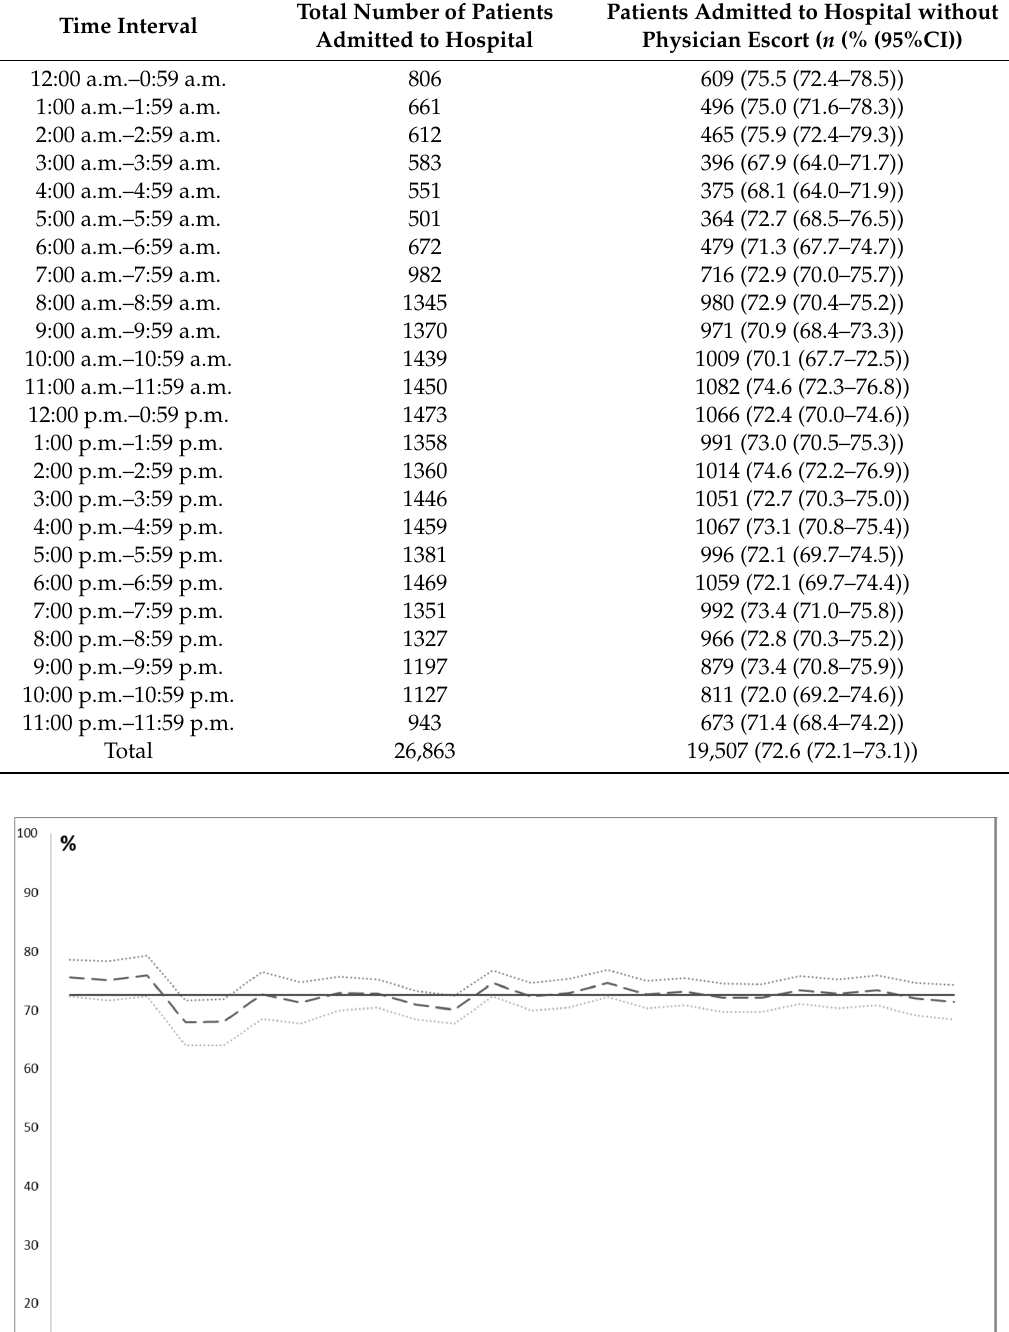
Table 3. Proportion of patients transported to hospital in relation to the time of the day. (Chi 2 ; p < 0.035). Time Interval